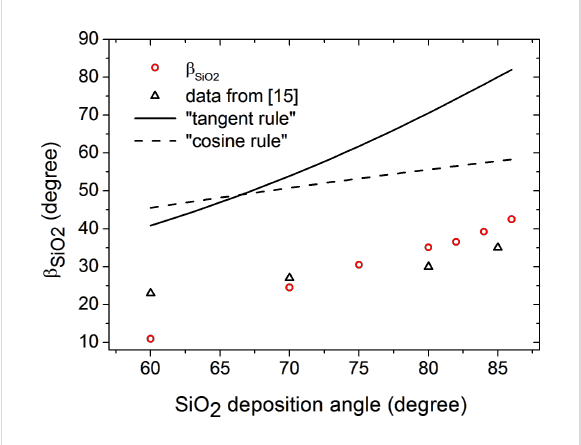
Figure 4: SiO 2 column tilt vs the SiO 2 deposition angle. The experi- mental data from [15] and the curves simulated according to the "tangent rule" [10] and "cosine rule" [11] are shown for comparison.